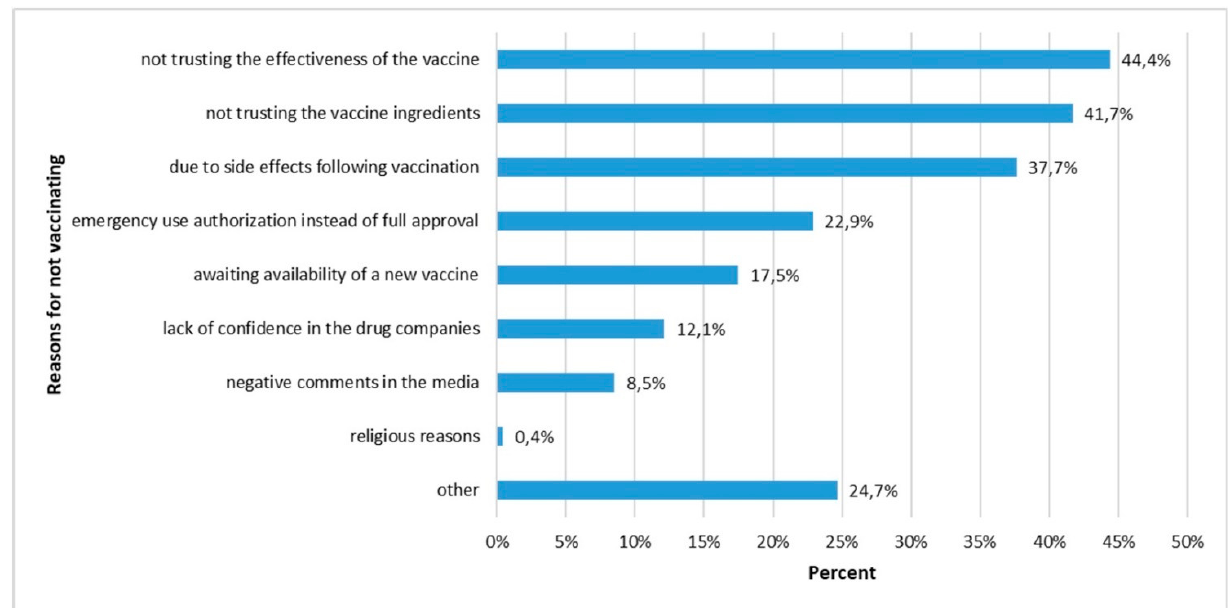
Figure 3. Reasons for not vaccinating that were indicated by the unvaccinated healthcare personnel .